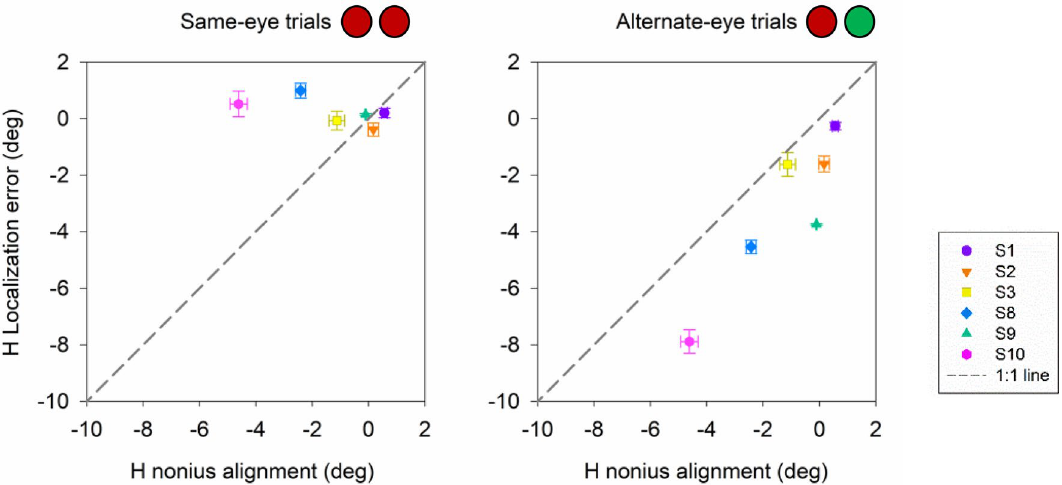
Figure 8. Scatter plot displaying correlation between horizontal nonius alignment and horizontal localization error (n = 6) for same-eye and alternate-eye viewing conditions. Color and shapes represent the mean and standard errors from individual subjects. Grey line is the 1:1 line.